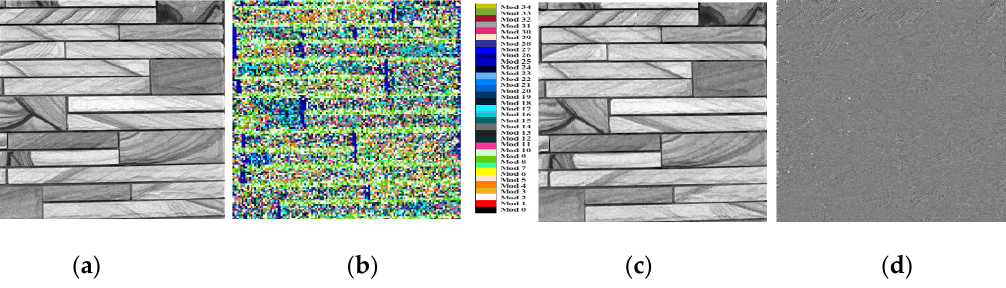
Figure 12. Illustrative example of HEVC intra-prediction efficiency: ( a ) original image of 1024 × 1024 pixels; ( b ) selected modes to predict the original image (each prediction mode is represented here by one among 35 different colors); ( c ) intra-predicted image; and ( d ) the residual image.